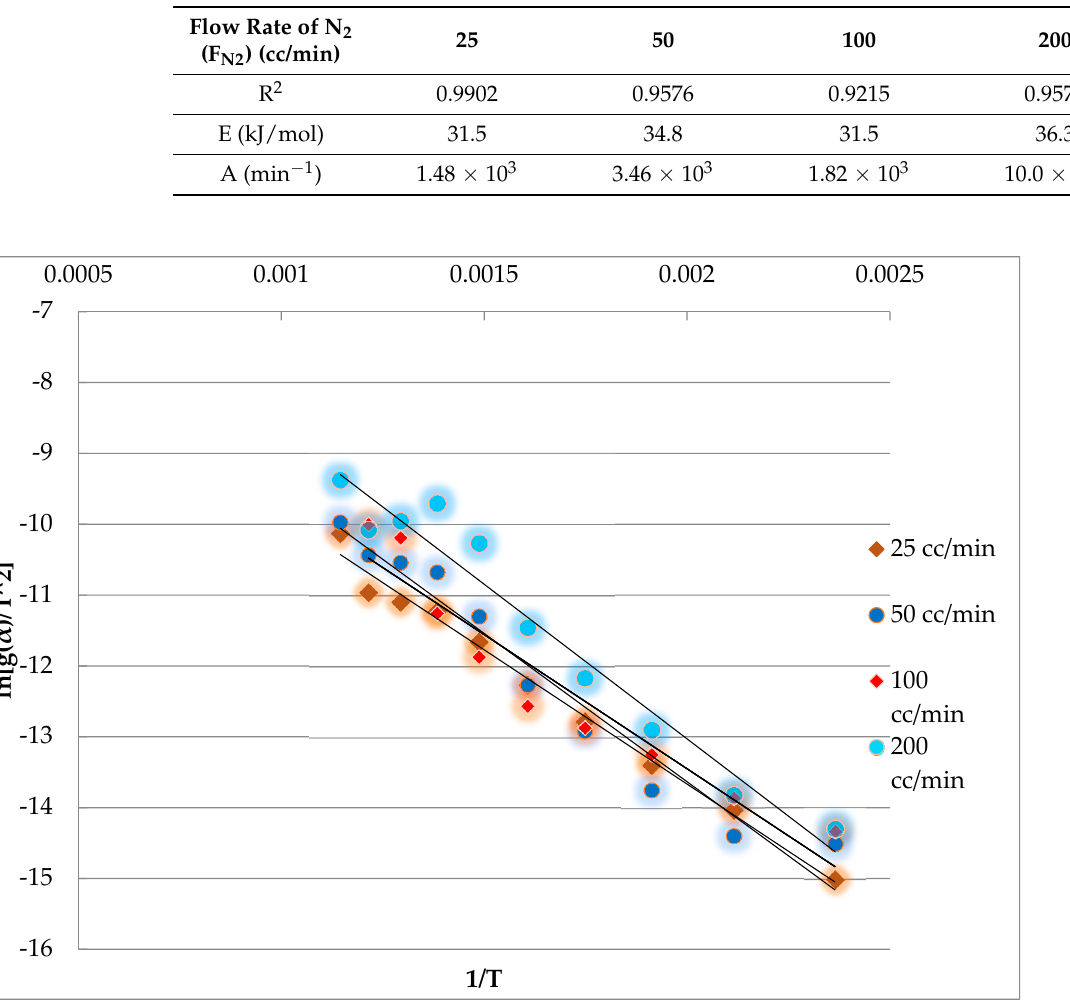
Table 5. Effect of carrier gas flow (q) rate on kinetic parameters E, A.